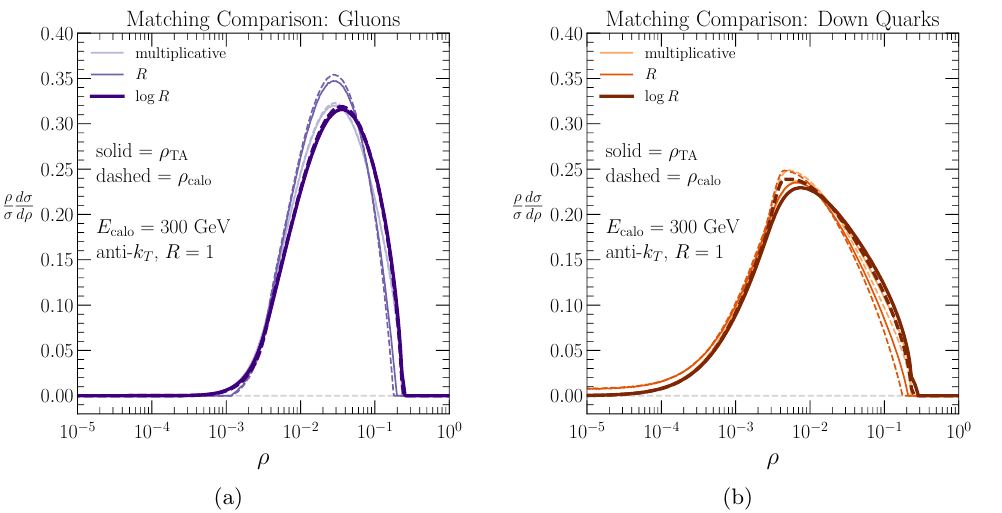
Figure 21 . Comparison of (cid:12)xed-order/resummed matching schemes for (a) gluon jets and (b) down-quark